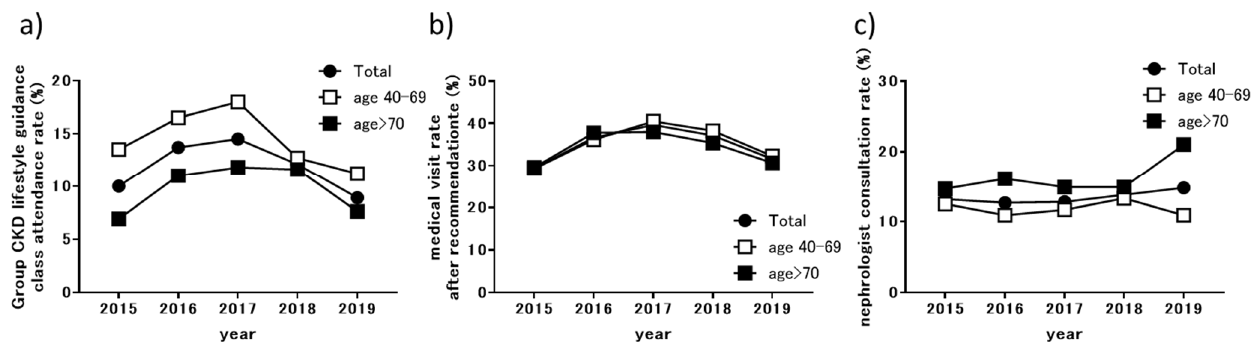
Figure 4. Response of examinees undergoing NHI health checkups to prefecture-wide CKD initiative: ( a ) group CKD lifestyle guidance class attendance rates; ( b ) medical visit rates after recommendation; ( c ) nephrologist consultation rates. NHI, National Health Insurance; CKD, chronic kidney disease.